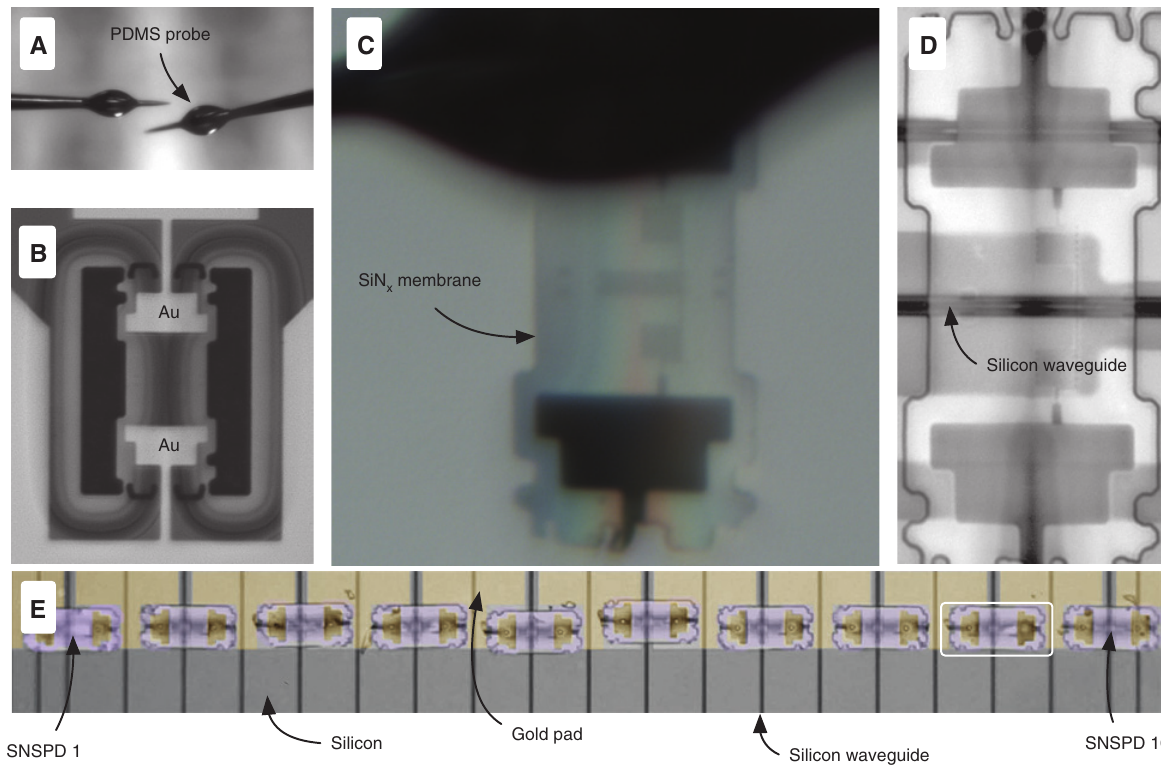
Figure 7: Micro-flip-chip integration of niobium nitride superconducting nanowire single-photon detectors. (A) Polydimethylsiloxane (PDMS) coated tungsten probes used to remove membrane SNSPDs from a silicon nitride substrate shown in (B). (C) SNSPD after being removed from the silicon nitride substrate. (D) SNSPD aligned and placed on a silicon photonic waveguide. (E) Ten SNSPDs aligned and placed on a silicon photonic waveguide